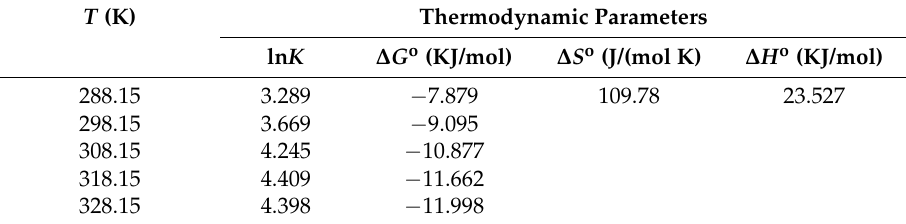
Figure 9. The effect of temperature on the adsorption of MB onto SPEN-Al-2 ( A ) and thermodynamic parameters for the adsorption of MB onto SPEN-Al-2 ( B ). Table 3. Thermodynamic constants of the adsorption of MB onto SPEN-Al-2.